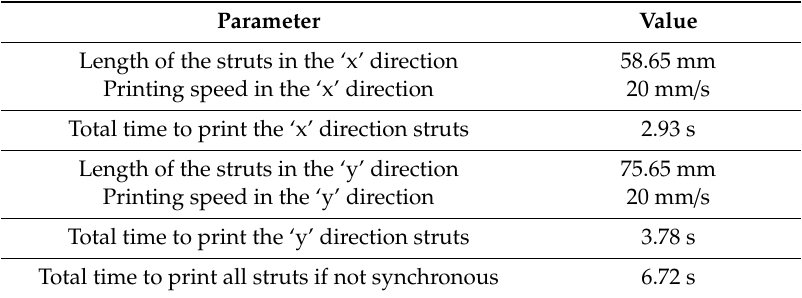
Table 3. Second scenario for comparison (industrial upscale): Calculation of the total time to print a mesh in the new proposed process once industrially upscaled.